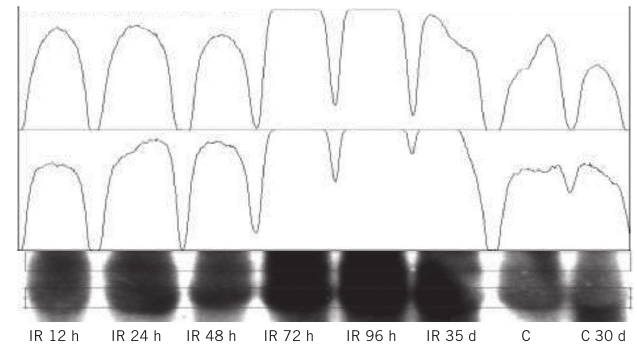
IR 12 figurE 5 − Electrophoretic profile of SG2 proteins after whole-body exposure to 5 Gy SG2: subgroup 2.